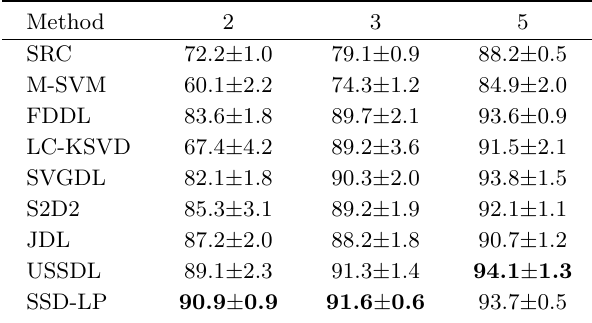
Table 1 Recognition rate for various methods, for different number of labeled training samples, for the AR database (Unit: